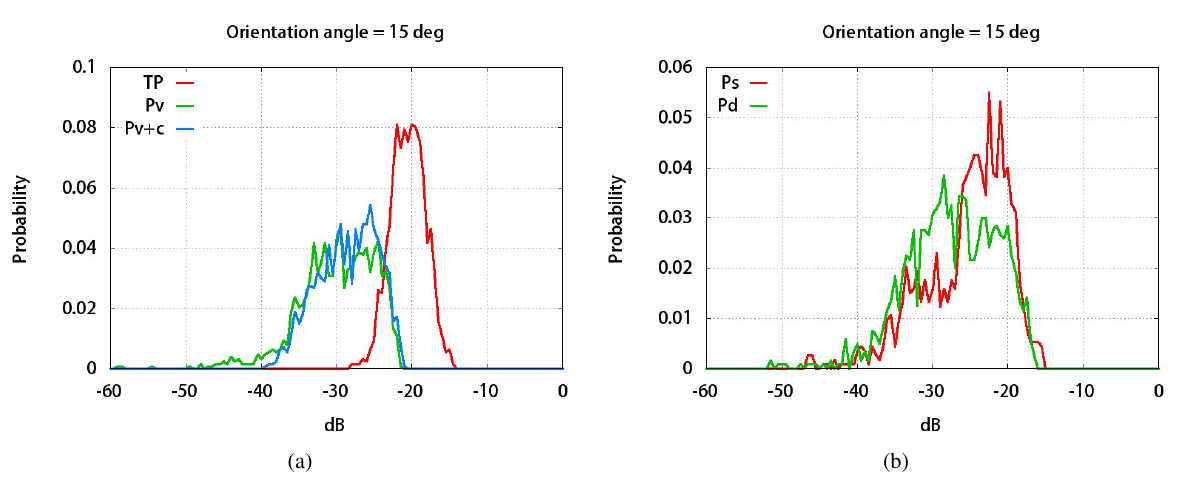
Figure 6. Histograms of scatterings when the orientation angle of the concrete blocks was set to 15 ◦ . (a) TP , P v , and P v + c , and